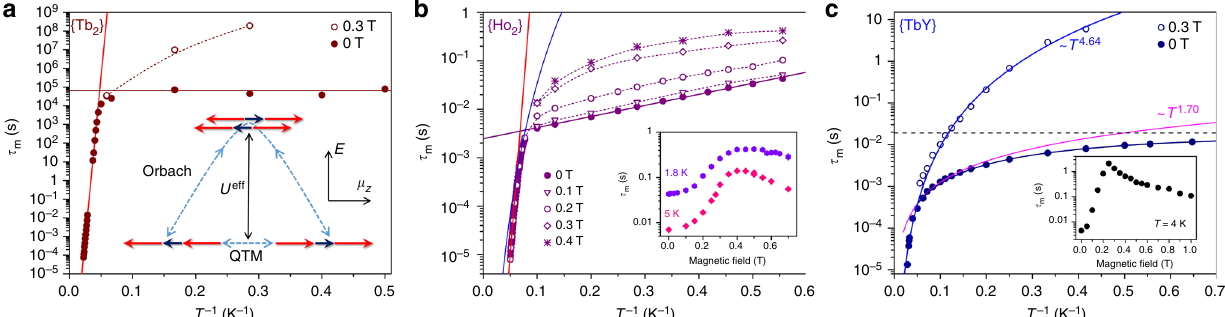
Fig. 5 Relaxation of magnetization in {Ln 2 } molecules. a magnetic relaxation times of {Tb 2 }, full dots are zero- fi eld data, open dots are in- fi eld data, red line denotes Orbach processes, solid horizontal line denotes QTM; the inset shows schematically two main relaxation pathways in {Tb 2 }: QTM and Orbach relaxation via an exchange-excited state, red arrows are Ln spin, blue arrow is a free electron spin; b magnetic relaxation times of {Ho 2 } at zero fi eld (full dots) and in different fi elds between 0.1 and 0.4 T, red and purple solid lines are Orbach processes, blue line is a possible Raman contribution (~ T 10.1 ); the inset shows magnetic fi eld dependence of relaxation times at 1.8 and 5 K; c magnetic relaxation times of {TbY}, dashed horizontal line is a QTM contribution to zero- fi eld relaxation, magenta line is a low-power process (~ T 1.70 ), dark blue line is a combination of both, light blue line is a Raman process (~ T 4.64